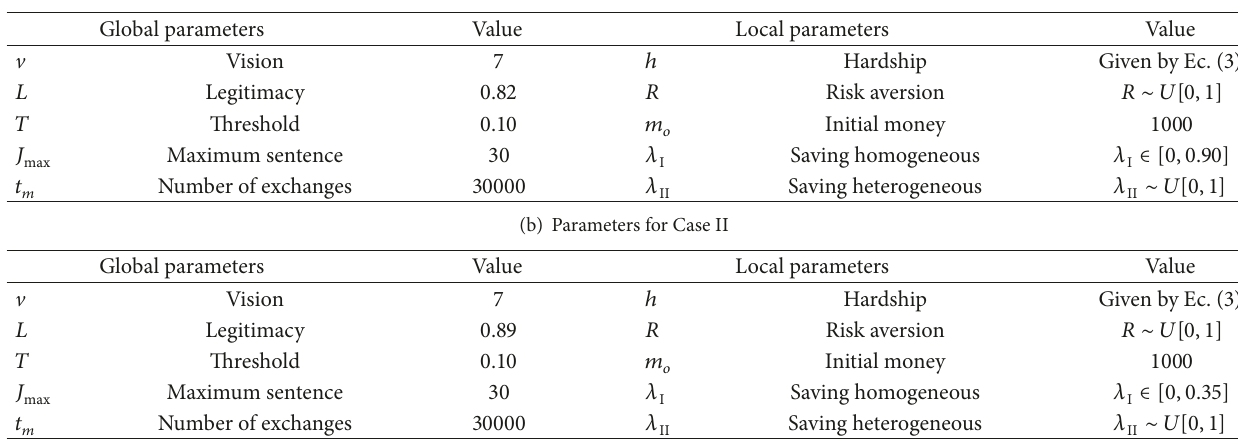
Saving heterogeneous 𝜆 II ∼ 𝑈[0, 1]